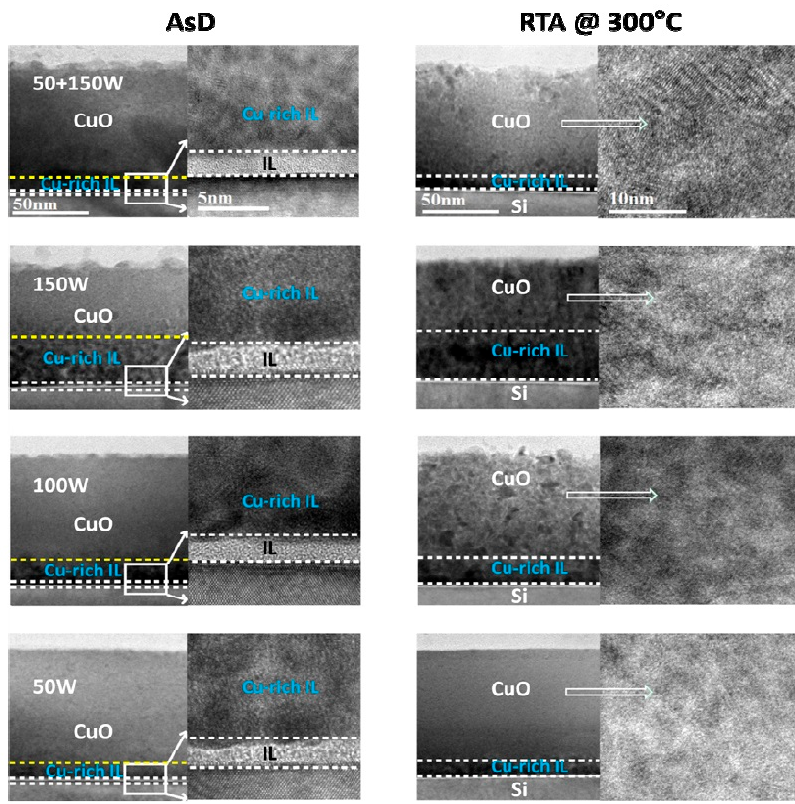
Figure 11. HRTEM image of p-CuO/n-Si hetreojunction. p-CuO was deposited on n-Si using different radio frequency power of 50 W, 100 W, 150 W and by using two-step sputter. There is significant impact of radio frequency power on the material quality and interface properties. Reprinted with permission from Journal of Applied Physics 116 , 074501 (2014) Copyright 2014, AIP Publishing LLC [42].